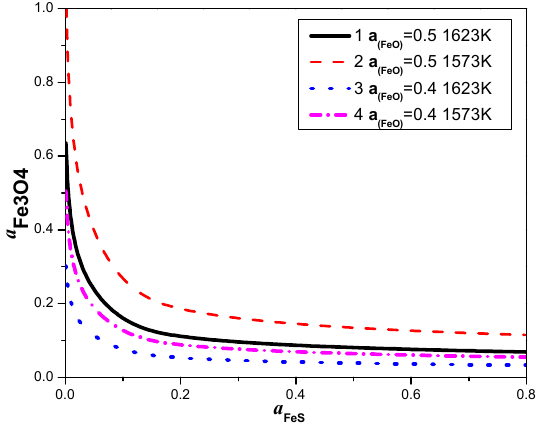
Figure 4. Relationship between a FeS and a Fe3O4 in molten slag.